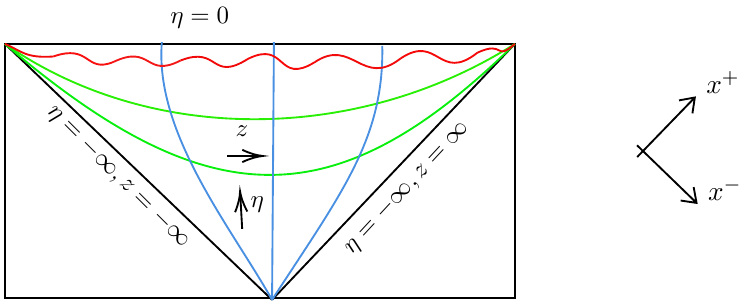
Figure 7 . The green curves correspond to curves of constant η and blue curves corresponds to cuves of constant z and red curve corresponds to φ = − 1